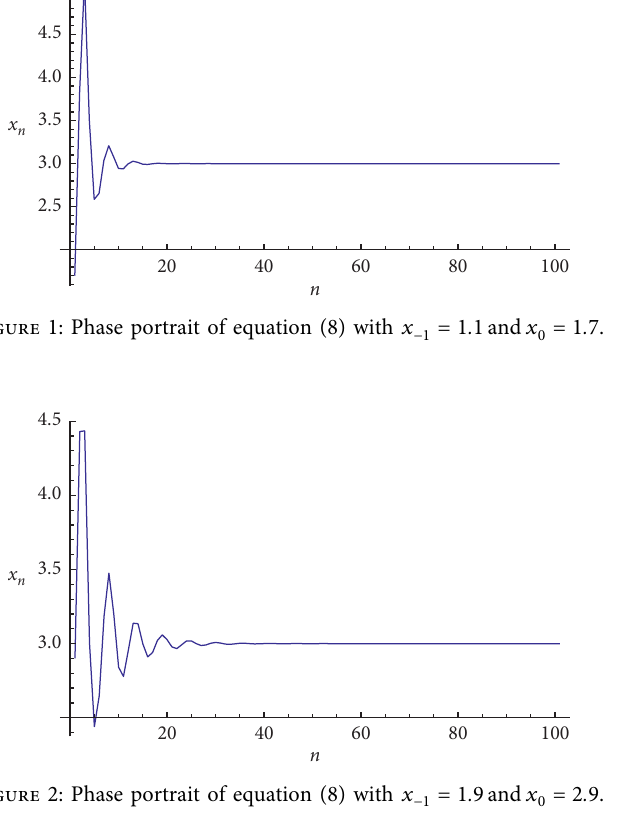
� 1 . 9and x � 2 . 9. − 1 0